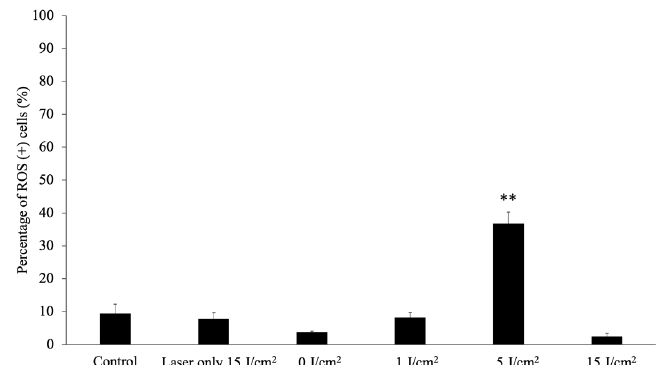
Figure 9. Reactive oxygen species assay. Reactive oxygen species (ROS) generation was assessed 4 h after laser irradiation using the Muse ® Oxidative Stress kit. The cells were then incubated with 8.0 μ g/mL glucose-conjugated chlorin e6 for 24 h at 37 °C. After washing with fresh media, the cells were irradiated with 650-nm laser light (10 mW/cm 2 ; 0, 1, 5, 15 J/cm 2 ). Data were analyzed using Dunn’s multiple comparison test. (** p < 0.01; 5 J/cm 2 vs. 15 J/cm 2 ). The results are presented as the mean ± standard deviation.